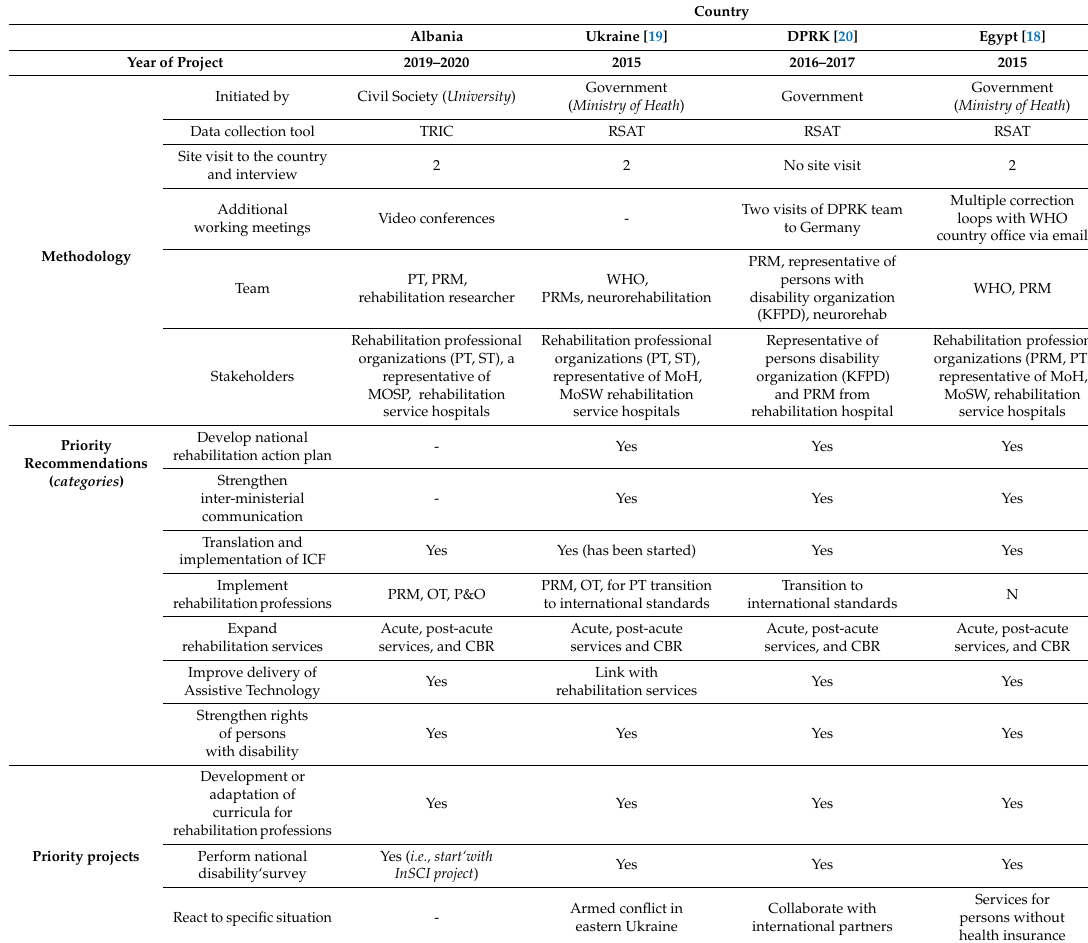
Table 2. Comparison of rehabilitation assessment in Albania, Ukraine, Democratic People’s Republic of Korea (DPRK), and